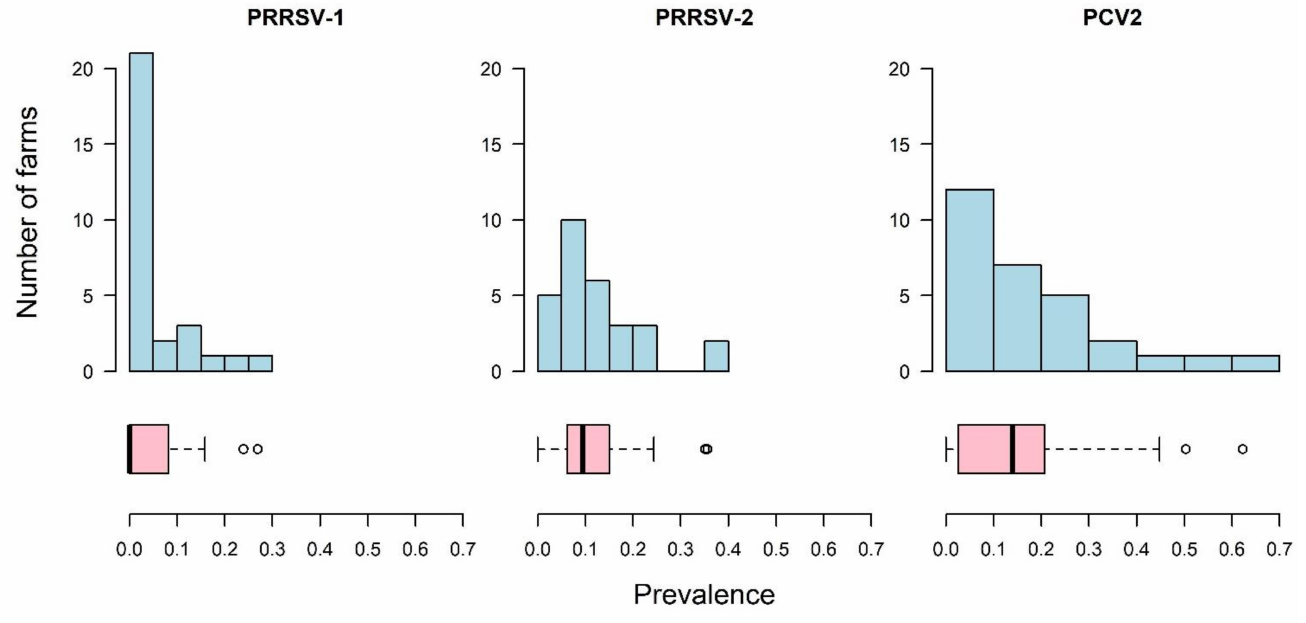
Figure 3. For 29 farms sampled in the HKSAR, the number of farms with, and corresponding prevalence of, porcine reproductive and respiratory syndrome virus European strain (PRRSV-1) and North American strain (PRRSV-2) and porcine circovirus type 2 (PCV2), shown in 10% increments from 0% to